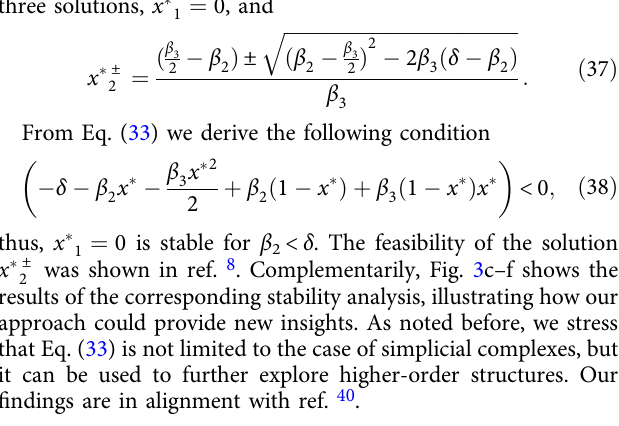
(Eq. (37)) and its stability (Eq. (38)), respectively. Here, x (cid:2)þ and 2 2